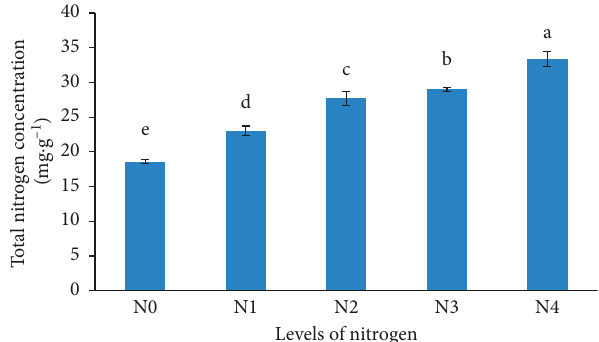
Figure 1: Effect of different levels of N on total nitrogen con- centration. Data labeled with different letters are significantly different at p < 0 .